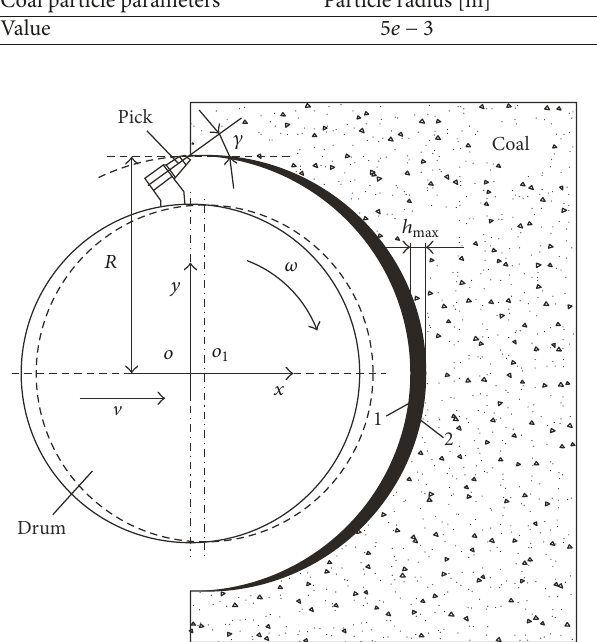
Figure 2: Schematic illustration of the Hertz-Mindlin contact model of coal